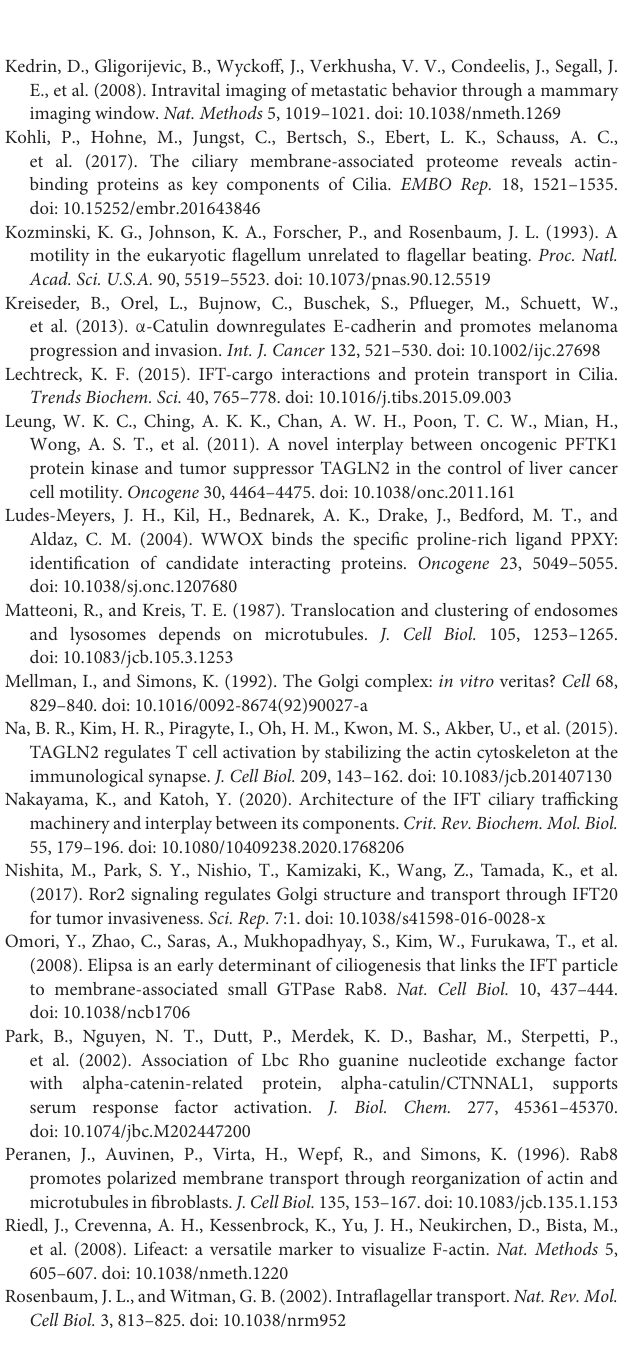
Supplementary Table 3 | Biotinylated protein identified in parental 4T1 cells, IFT20-DMSO and IFT20-biotin groups. Supplementary Table 4 | Biotinylated protein commonly identified in IFT20-DMSO and IFT20-biotin groups. Supplementary Table 5 | Biotinylated protein uniquely identified in IFT20-biotin